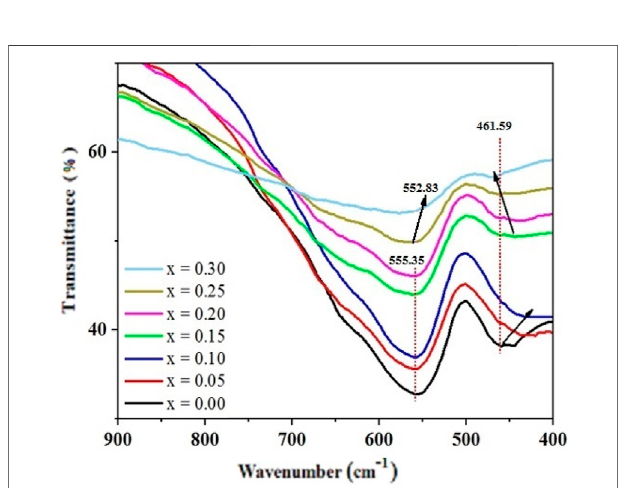
FIGURE 7 | Room-temperature magnetization curves of Cd x Mg 0.30- x Cu 0.20 Zn 0.50 Fe 2 O 4